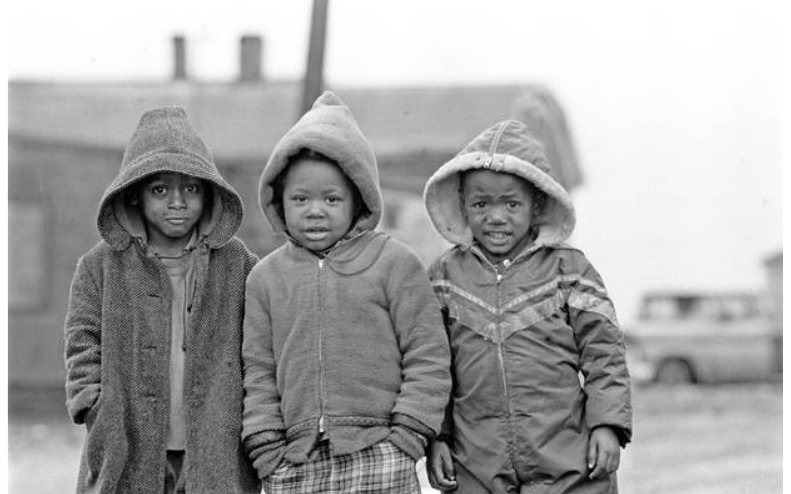
Figure 5. The children of Africville pose for a picture in 1967. Photo by Erik Christensen.